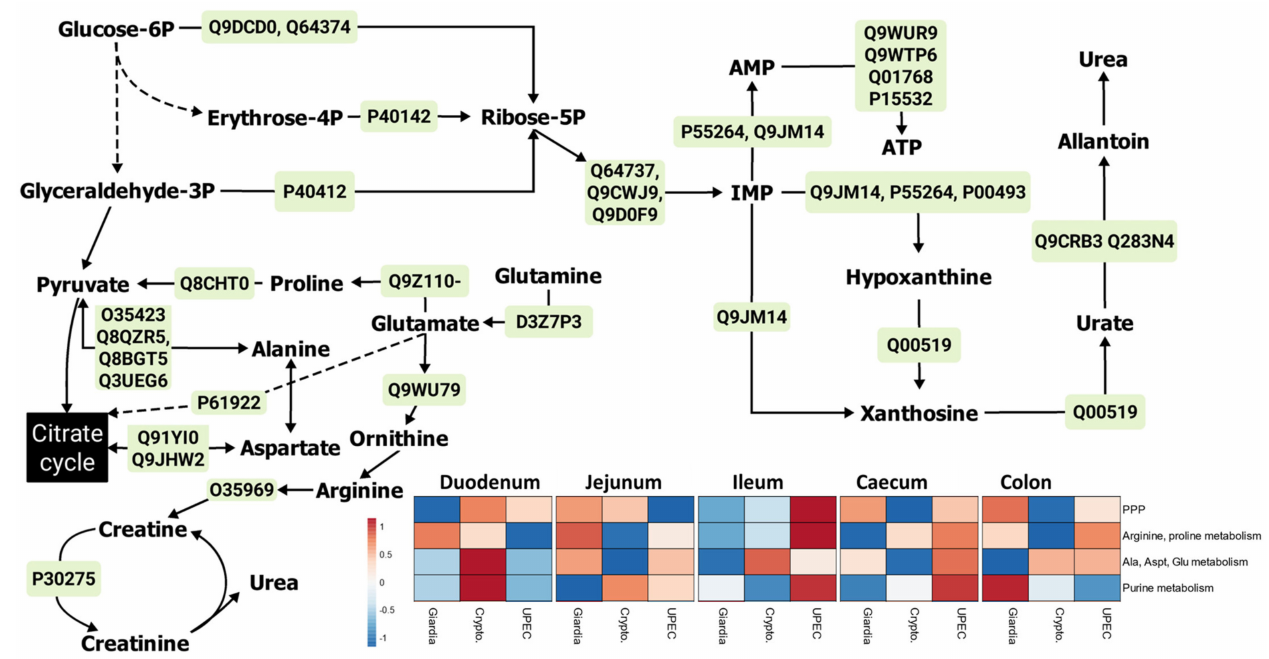
Figure 4. The major proteins (green boxes) and metabolites contributing to the pentose phosphate pathway and amino acid–sugar interconversions in mouse gut during giardiasis. The heatmap represents relative upregulation (red) and downregulation (blue) of individual pathways in the mice with infected gut with respect to the uninfected mice. Note: The protein identifiers (green boxes) refer to the Uniprot IDs. The heatmaps were designed using the Clustvis web tool [24]. Details for major proteins (Figure S5) and metabolites (Table S2) are provided in the Supplementary